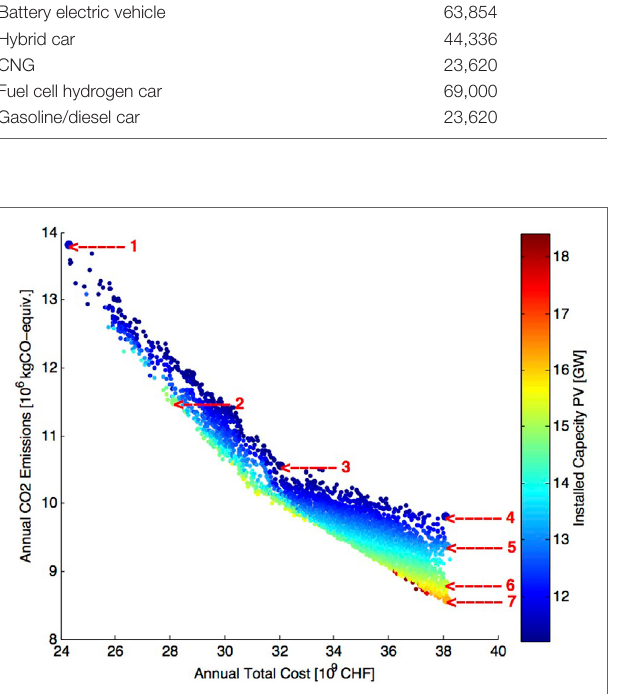
FigUre 11 | Annual CO 2 emissions VS annual total cost VS PV installed capacity.